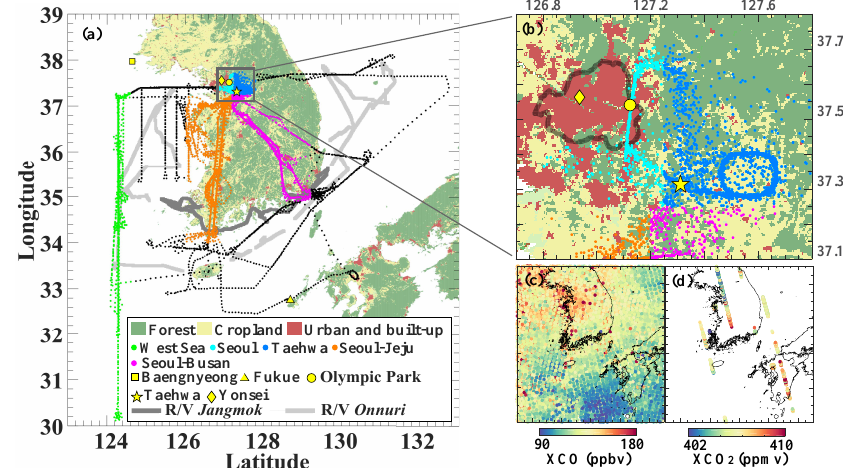
Figure 1. Domain of the study and KORUS-AQ measurements used in this study. Panel (a) shows land cover of the domain (Broxton et al., 2014), DC-8 aircraft tracks, ship tracks, and location of ground sites. The airborne measurements are classified into five groups (the West (Yellow) Sea, Seoul, Taehwa, Seoul–Jeju jetway, and Seoul–Busan jetway), as marked in bright green, bright blue, mazarine blue, orange, and magenta. The ground sites are labeled with bright yellow markers. The Olympic Park and Yonsei sites are located in urban regions (Seoul) while the Baengnyeong and Fukue (Kanaya et al., 2016) sites are located in remote regions. The Taehwa (Kim et al., 2013) site is located in a forest near Seoul. Tracks of the two ships are marked in dark grey (R/V Jangmok ) and light grey (R/V Onnuri ). Also shown in panel (b) is the zoomed-in version of the grey box in panel (a) . Panel (c) shows a composite MOPITT XCO retrievals during KORUS-AQ campaign while panel (d) shows OCO-2 XCO 2 retrievals in the same time period.